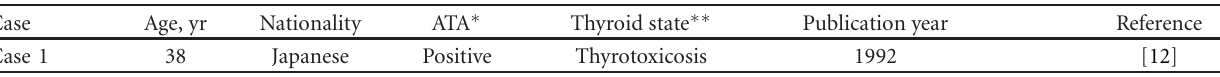
Table 4: Postpartum hypopituitarism (Sheehan’s syndrome: SS) and postpartum autoimmune thyroiditis (PPAT): a review of the